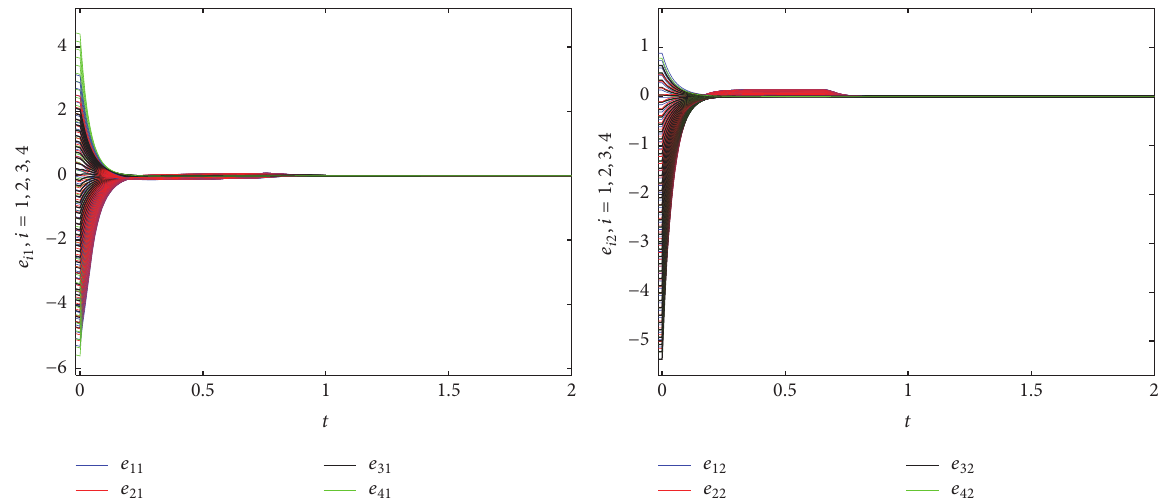
Figure 7: Time evolution of synchronization errors for (26) with different initial